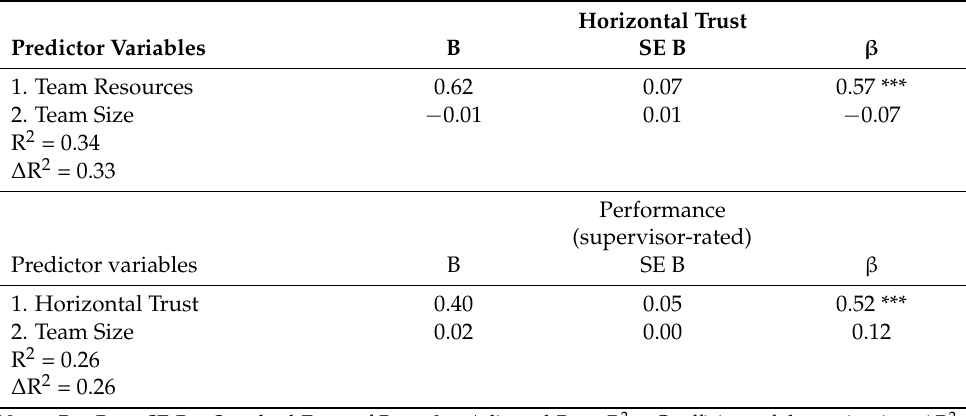
Table 5. Regression analyses by aggregating data (N =